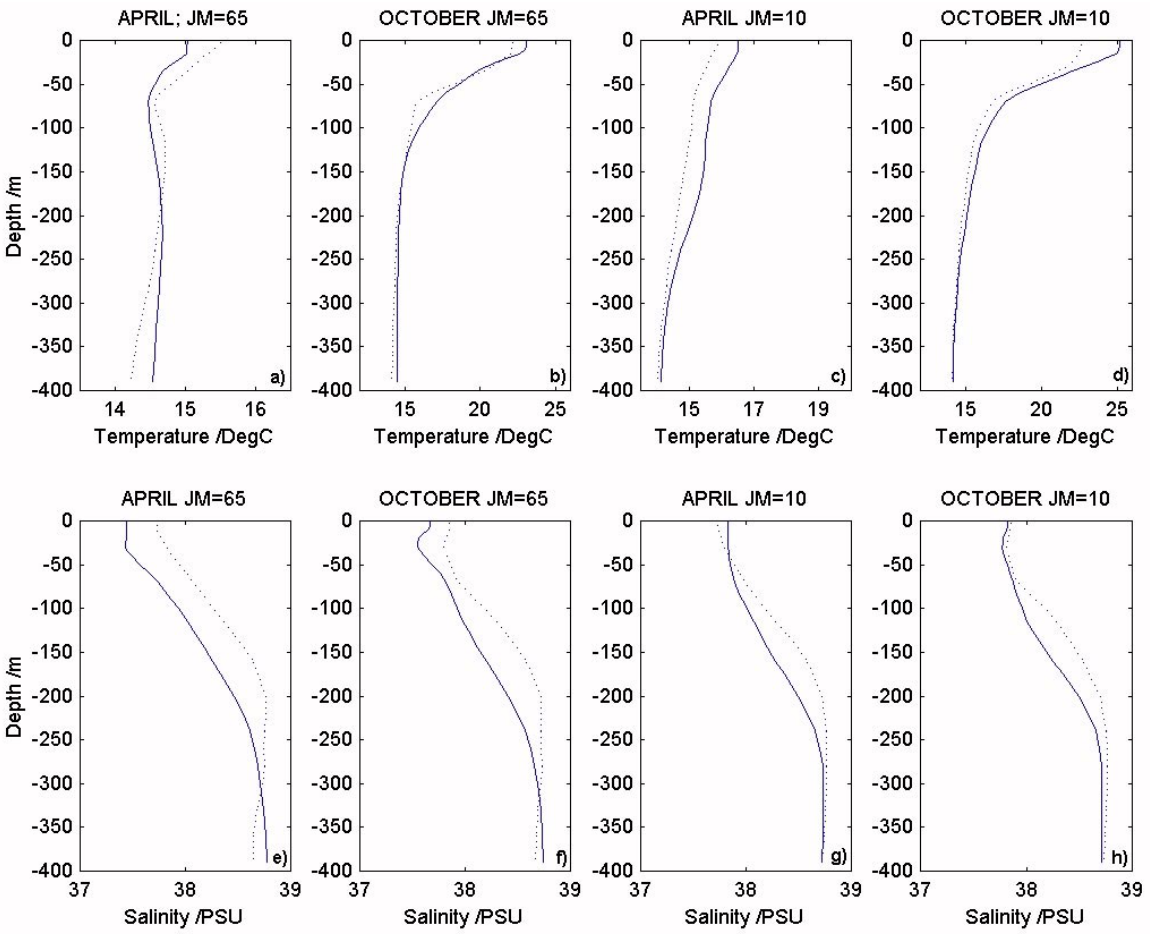
Fig. 6. Comparison between the modelled (solid line) and Med6 climatological (dotted line) temperature (a–d) and salinity (e–h) profiles at locations in the middle of the Malta Channel ( IM = 35 ,JM = 65; (36.4 ◦ N, 14.4 ◦ E)) and to the south of Malta ( IM = 35 ,JM = 10; (36.4 ◦ N, 14.4 ◦ E)), respectively, and at two different periods of the year (April and October). Climatological profiles are taken from monthly averaged fields. Modelled profiles are taken from 10-day averaged fields calculated from day 10 → 20 of the